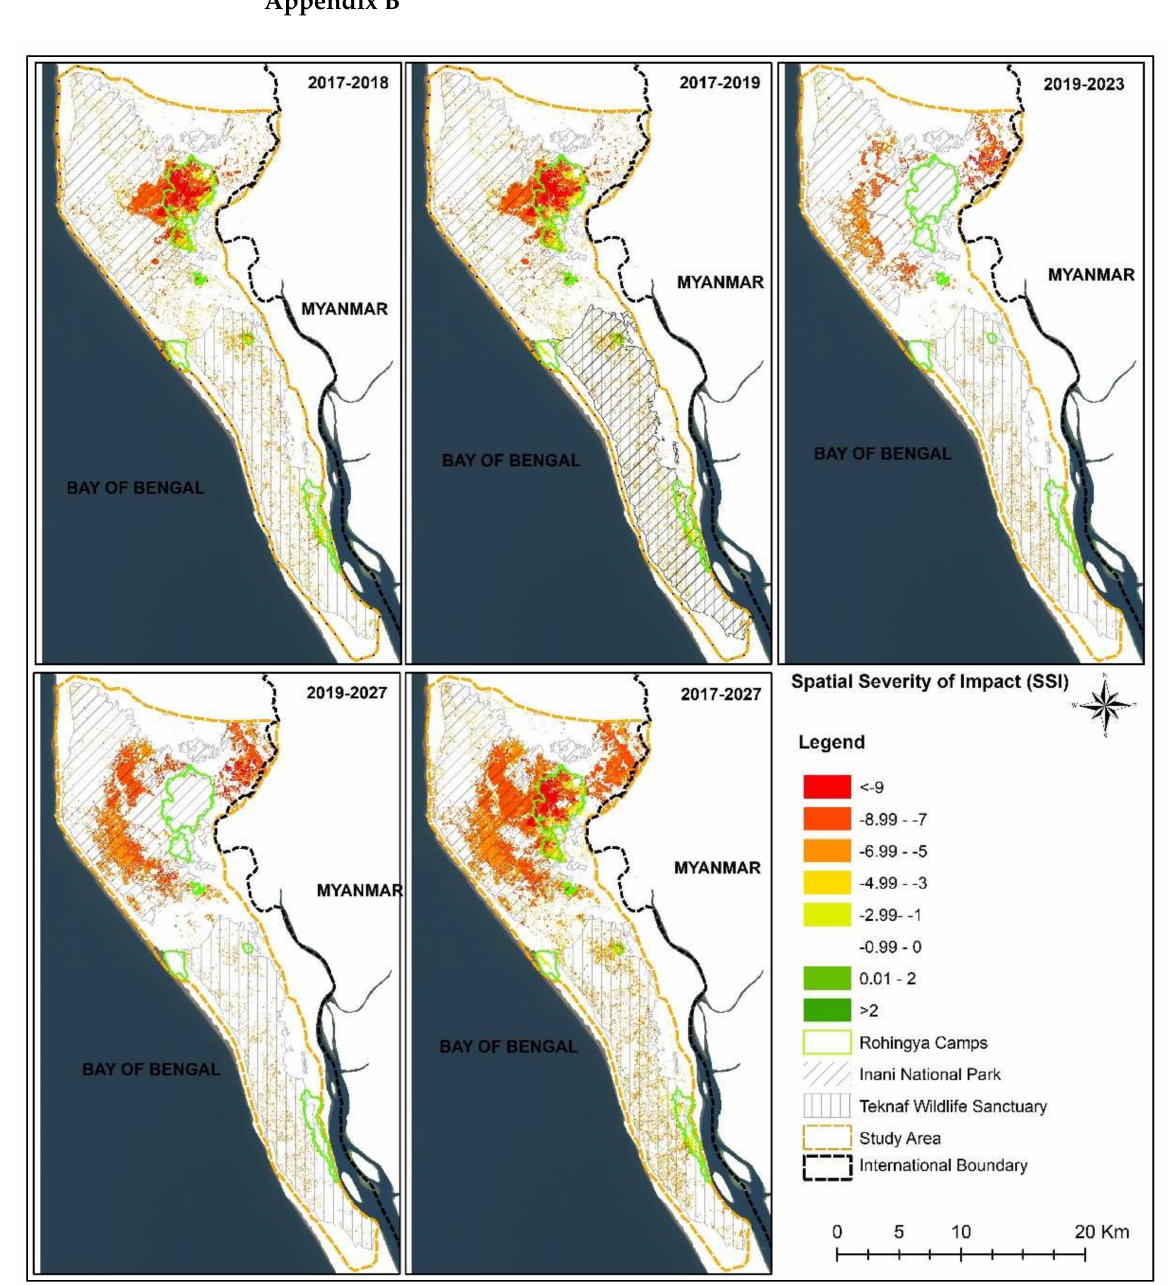
Figure A1. The complete scenario of the SSI for the whole study